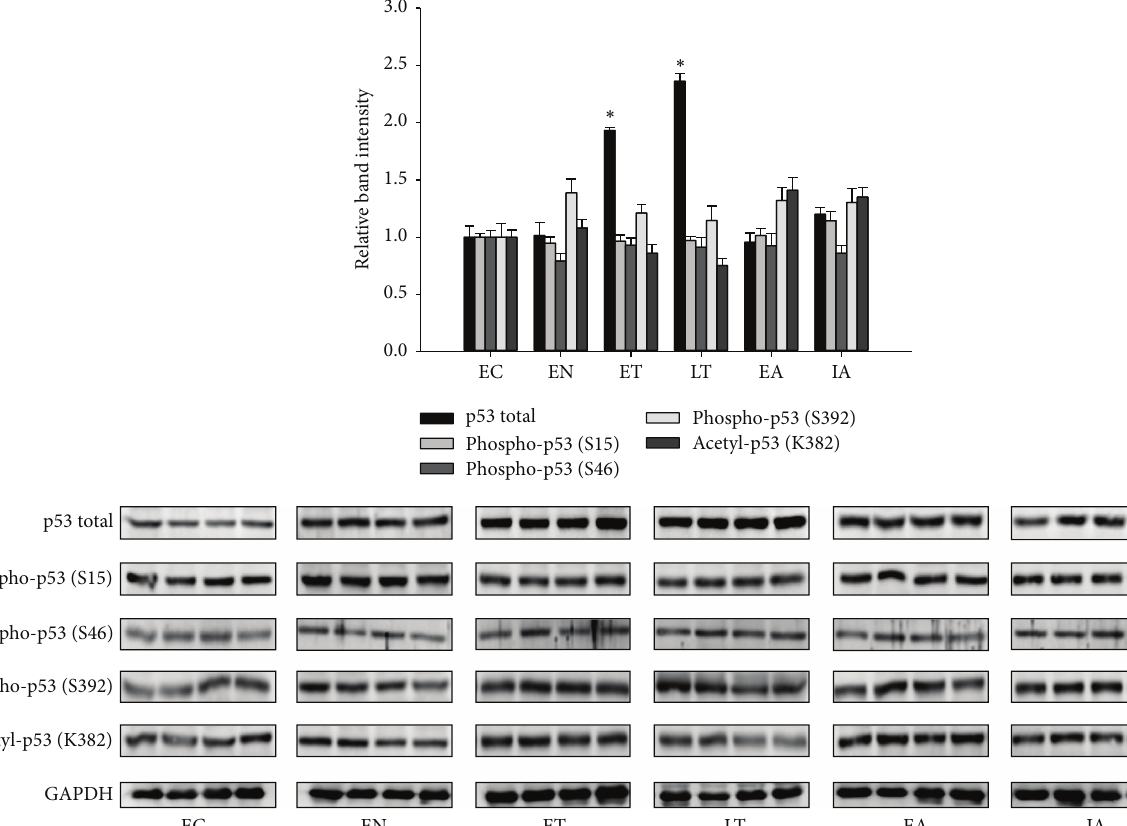
Figure 1: p53 protein expression and posttranslational modifications in the ground squirrel skeletal muscle over six stages of the torpor cycle. Stages of torpor are EC (euthermic in cold room), EN (entry into torpor), ET (early torpor), LT (late torpor), EA (early arousal), and IA (interbout arousal); see Section 2 for more details. Relative protein levels and Western blots are shown for total p53, p53 phosphorylated at serine 15, 46, and 392, p53 acetylated at lysine 382, and the housekeeping protein GAPDH. Data show means ± SEM, 𝑁 = 4 -5 independent trials on tissues from different animals. ∗ denotes significant statistical difference from EC values, 𝑝 < 0.05